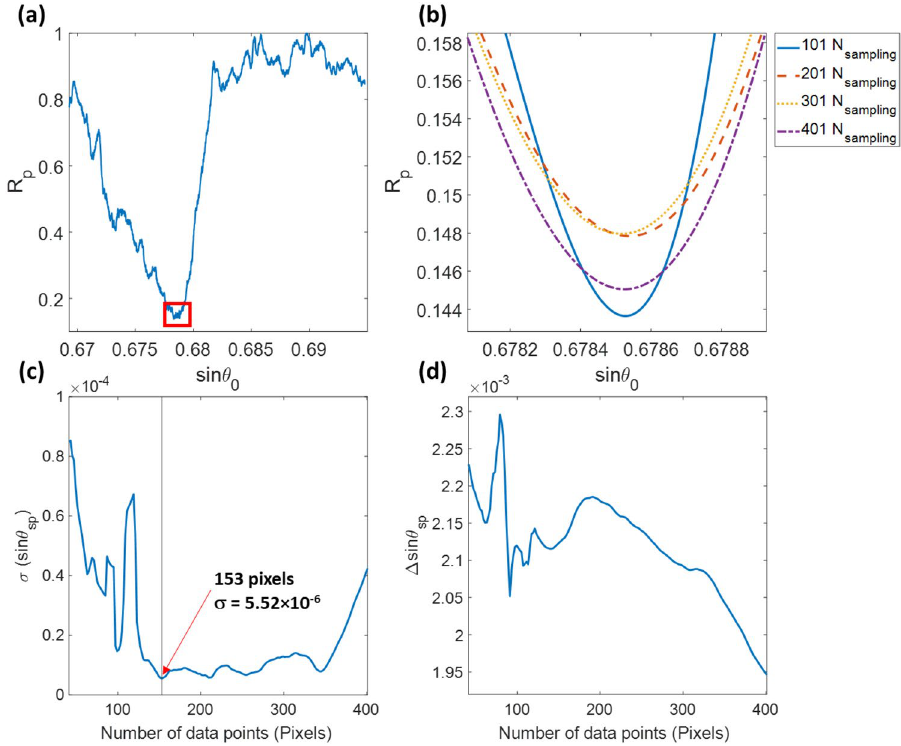
Figure 8. ( a ) Average line-scan calculated from 1944 rows of the first frame of the air case, ( b ) cubic polynomial fitting curves for data points of 101 (solid blue curve), 201 (dashed red curve). 301 (dashed yellow curve). 401 (dashed purple curve), ( c ) σ of 100 recovered sinθ sp values for each data point width, and ( d ) Δsinθ sp between the air and 150 psi cases for each data point width.